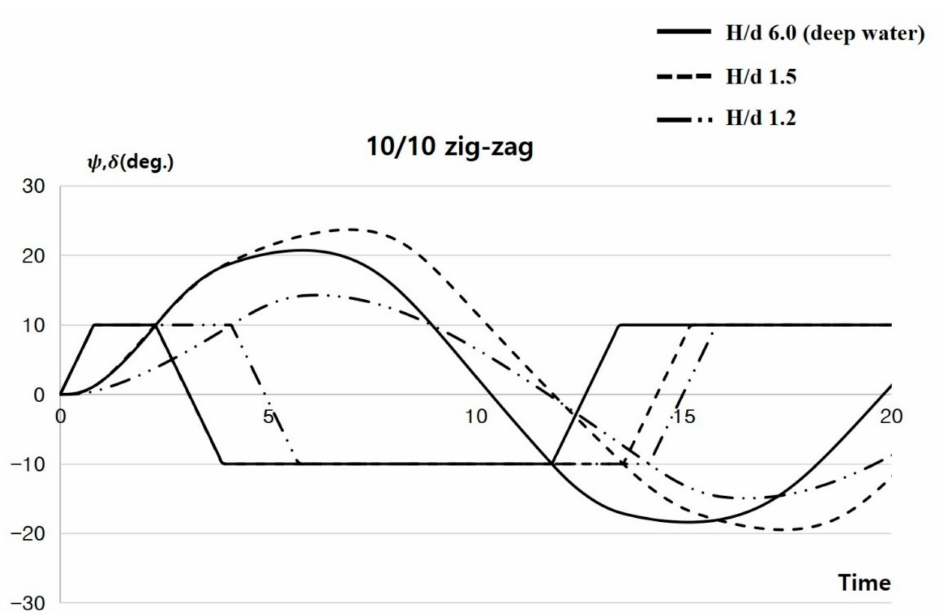
Figure 12. Comparison of 10/10 zig-zag simulation results by ship-draft to water-depth